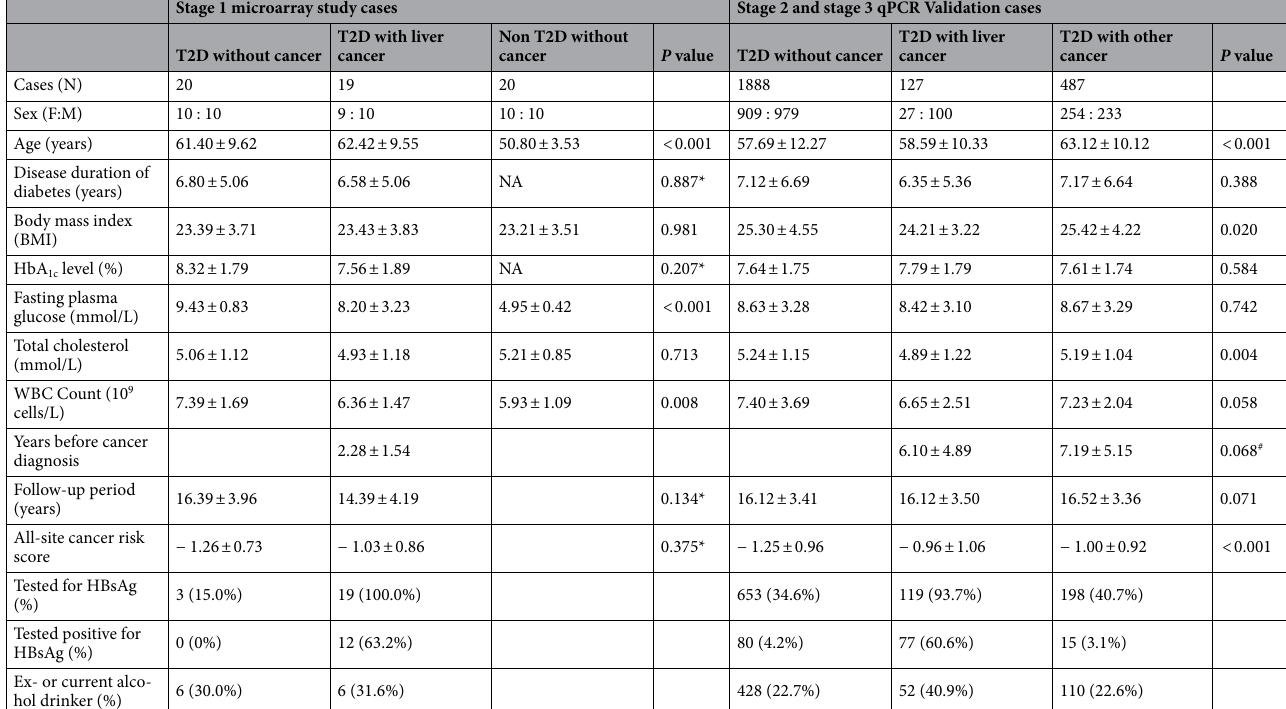
Table 1. Characteristics of the patients selected for stages 1, 2 and 3 of the study. Data were presented as mean ± standard deviation. For stage 1 microarray study, the differences among group means were compared by analysis of variance, ANOVA excepted stated otherwise. *T2D without cancer were compared to T2D with liver cancer using the t-test. # T2D with liver cancer were compared to T2D with other cancers using the